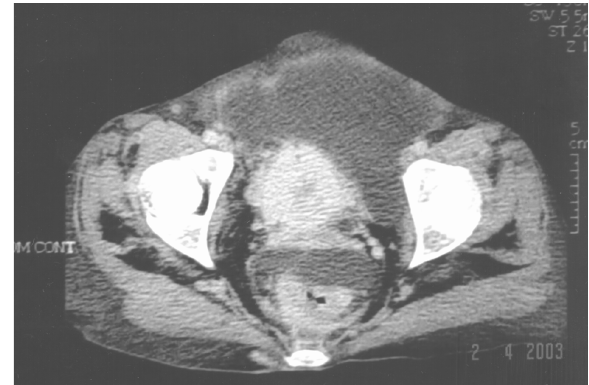
Figure 1 – Abdominal computerized tomography showing bilat- eral hydronephrosis and voluminous ascites.